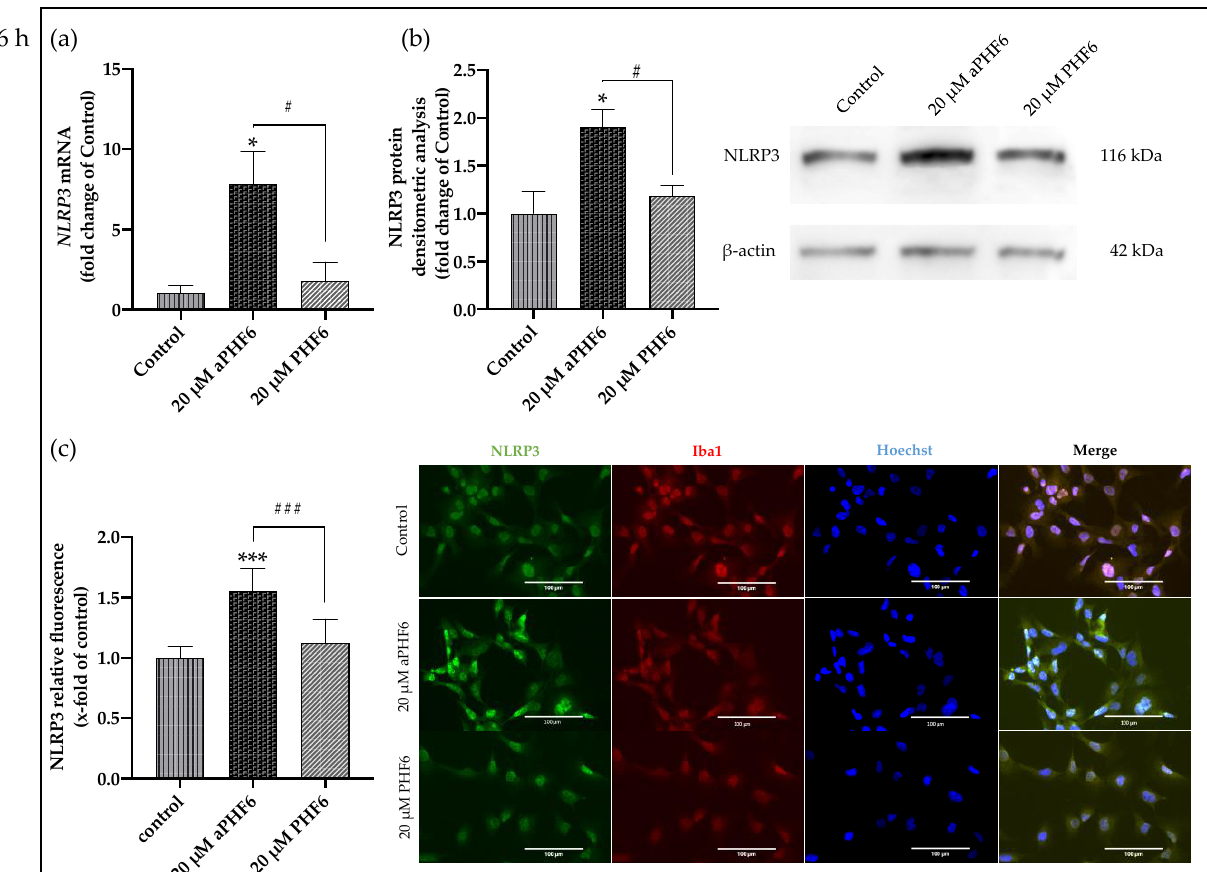
stimulation in HMC3 cells compared to the control group (Figure 3b), whereas after 24 h, no shifts were detected (Figure 3e). With the 20 µ M PHF6, however, no significant increase in protein expression was observed at both time points. Immunofluorescence staining of cells was performed using Iba1, NLRP3, and Hoechst (nuclear staining). Around a 1.5-fold increase in NLRP3 fluorescence intensity after 6 h of 20 µ M aPHF6 stimulation was observed, as quantified by ImageJ (Figure 3c). After 24 h, however, NLRP3 intensity was found comparable to the control levels across all different groups, with no significant increase in protein expression being observed (Figure